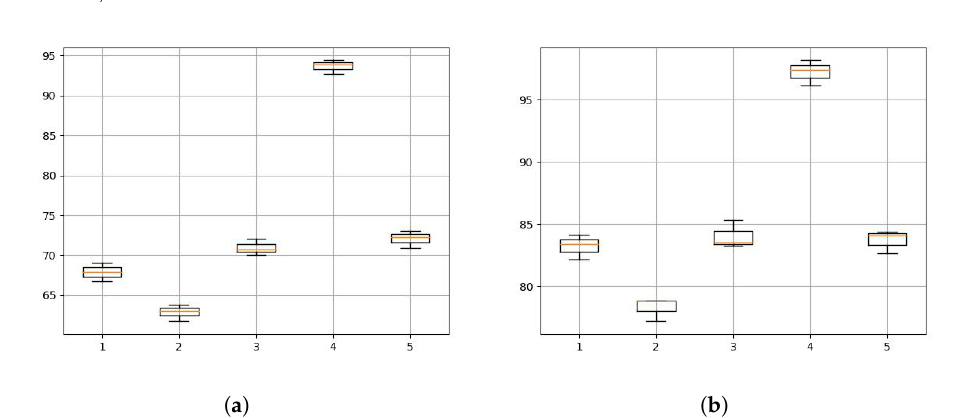
Figure 11. Accuracy of motion recognition under different orientations. ( a ) Using CSI data. ( b ) Using human velocity distribution.